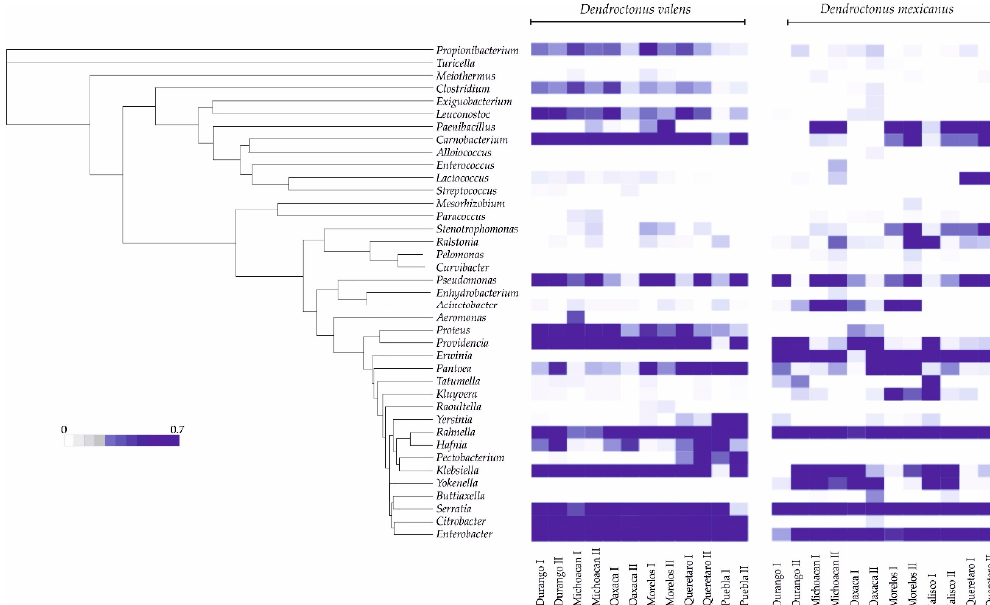
Figure 3. Heatmap of representative sequences of operational taxonomic units (OTUs) of Dendroctonus valens and D. mexicanus in different localities. The range of colors indicates the OTUs relative abundance for each sample; dark colors indicate higher abundance and light ones lower abundance.